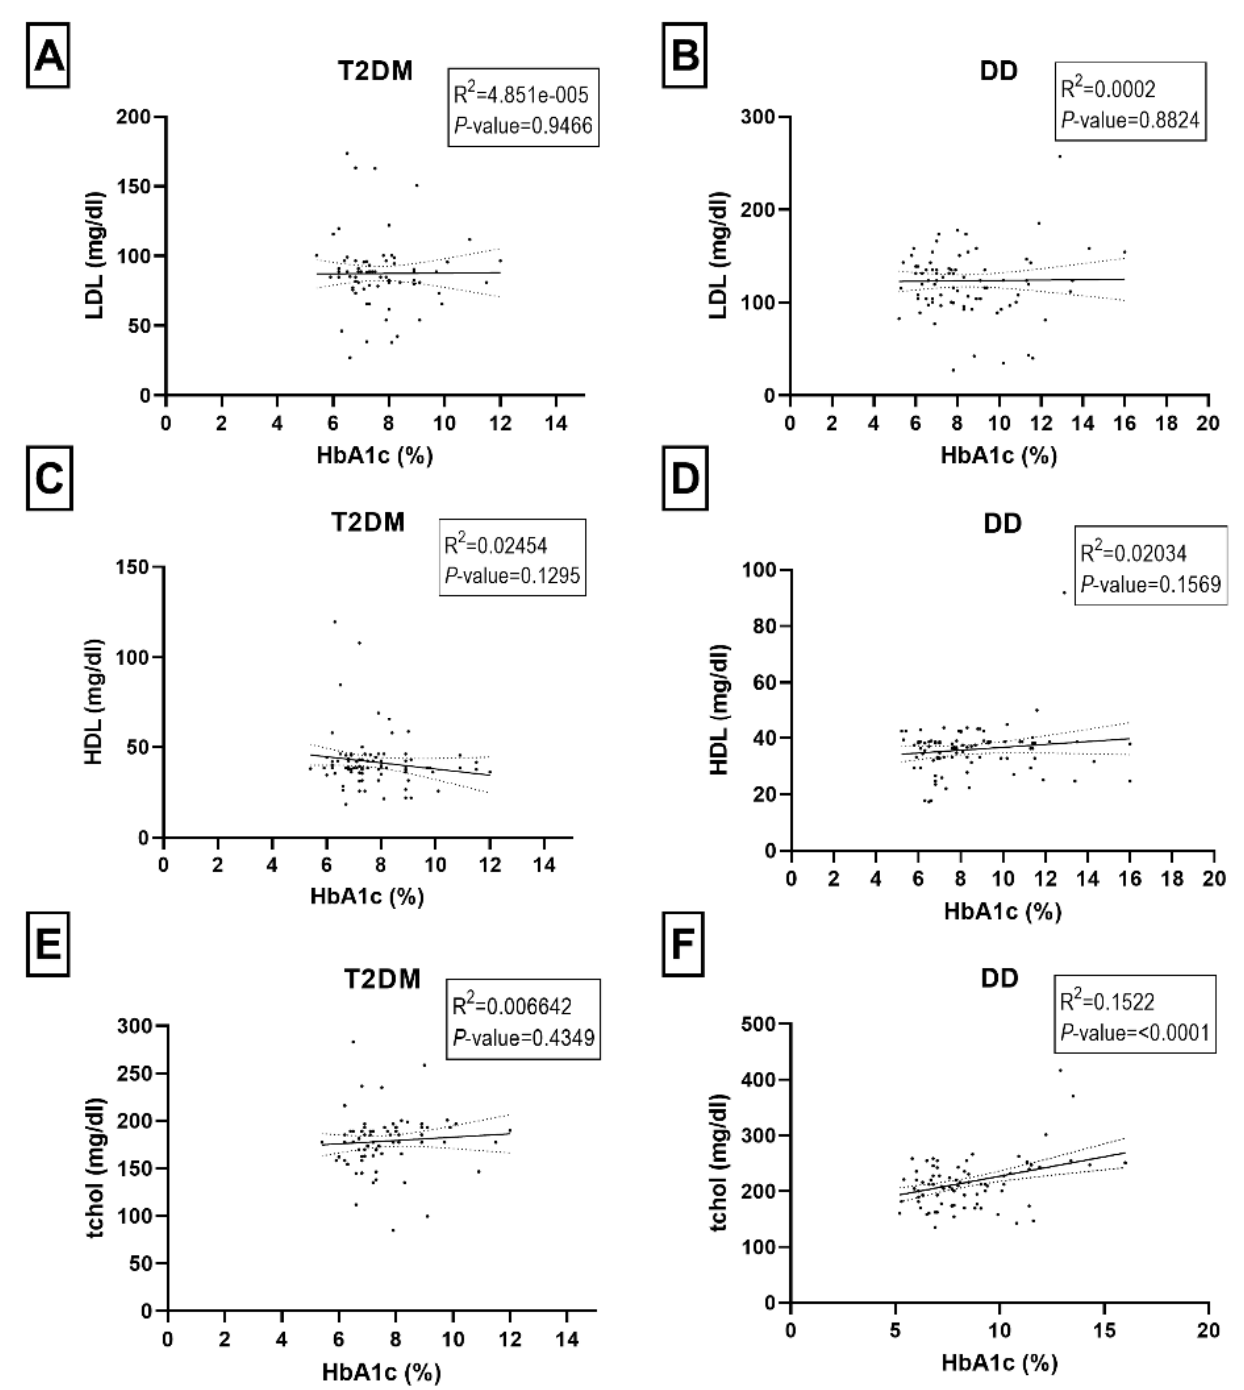
Figure 3. Relationship between HbA1C (%) and biomedical parameters of low-density lipoprotein (LDL mg/dl) ( A , B ), high-density lipoprotein (HDL mg/dl) ( C , D ), and total serum cholesterol (tchol mg/dl) ( E , F ) in T2DM and DD group. Each dot of the scattered plot represents the data of individual participants.